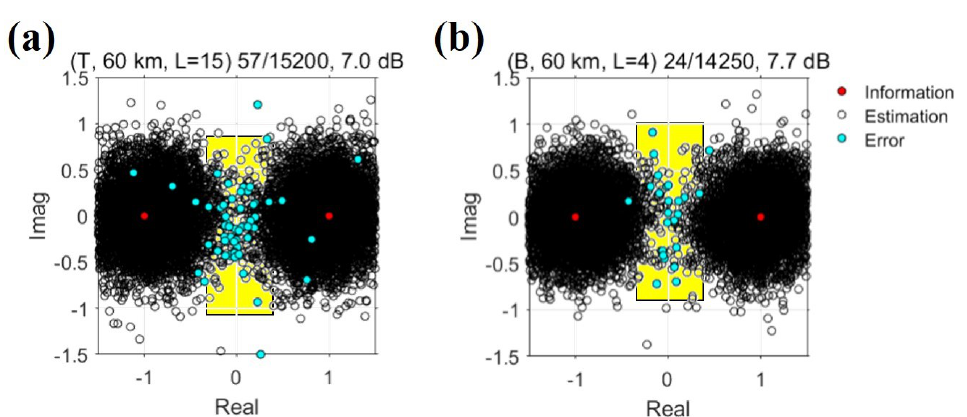
Figure 11. Performance comparison of the temporal and beam diversity methods when the order of diversity is maximum; ( a , b ) show the performance of the beam and temporal diversity methods, respectively. The yellow boxes indicate the area around the origin, and cyan filled circles indicate symbols corresponding to errors. In this experiment, the beam diversity method, which utilizes the features of the spatial filter, outperformed the temporal diversity